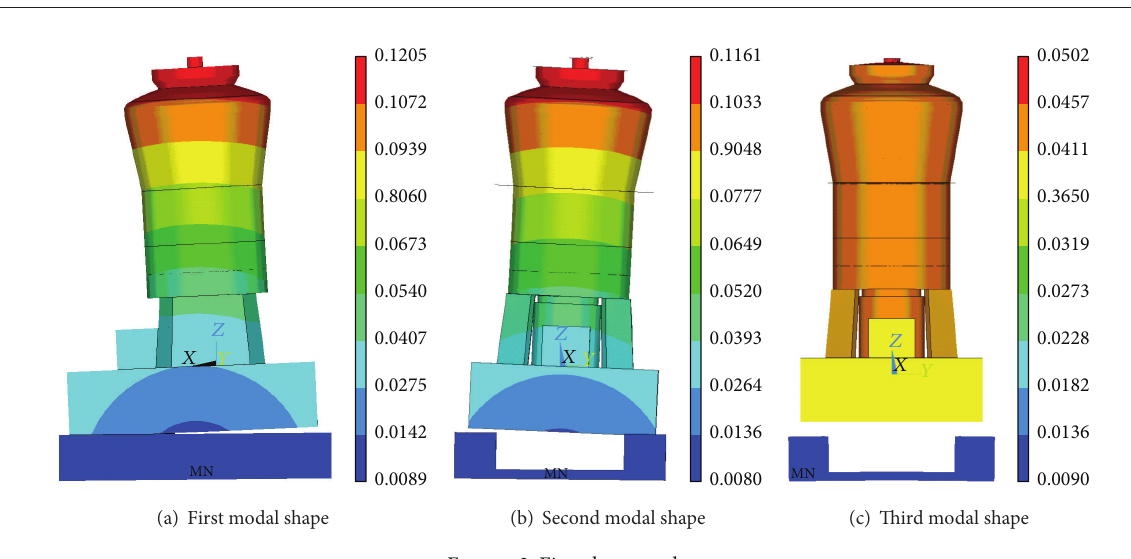
Figure 3: First three modes.